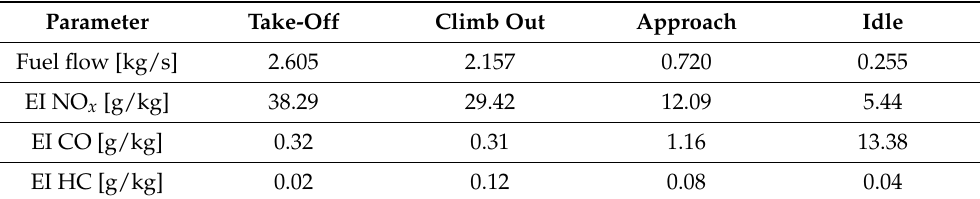
Table 2. Example ICAO engine emissions data for Rolls Royce Trent 970-84 engine. Data derived from